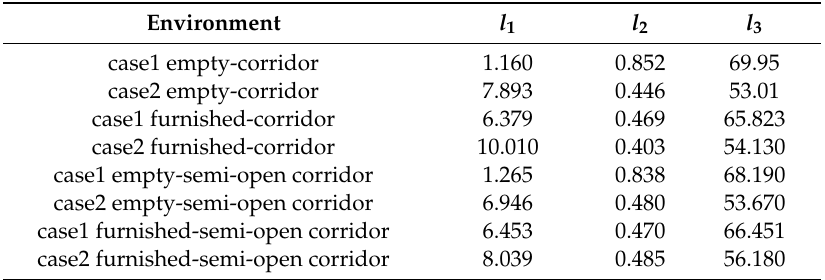
Table 5. Numerical modeling parameters for OPL in both corridor and semi-open